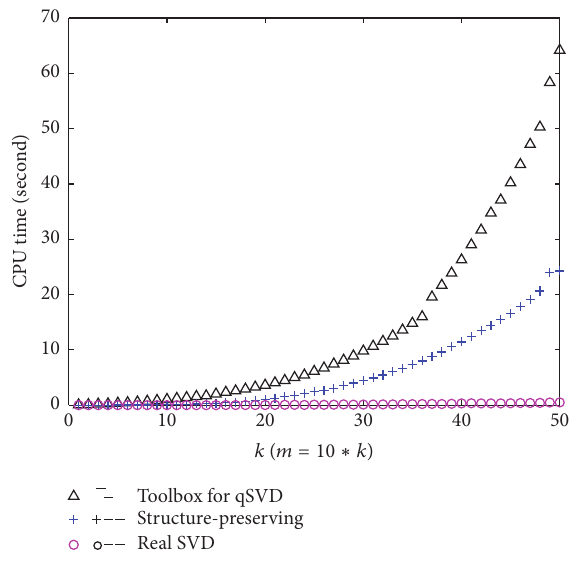
Figure 2: Comparison of the SVD